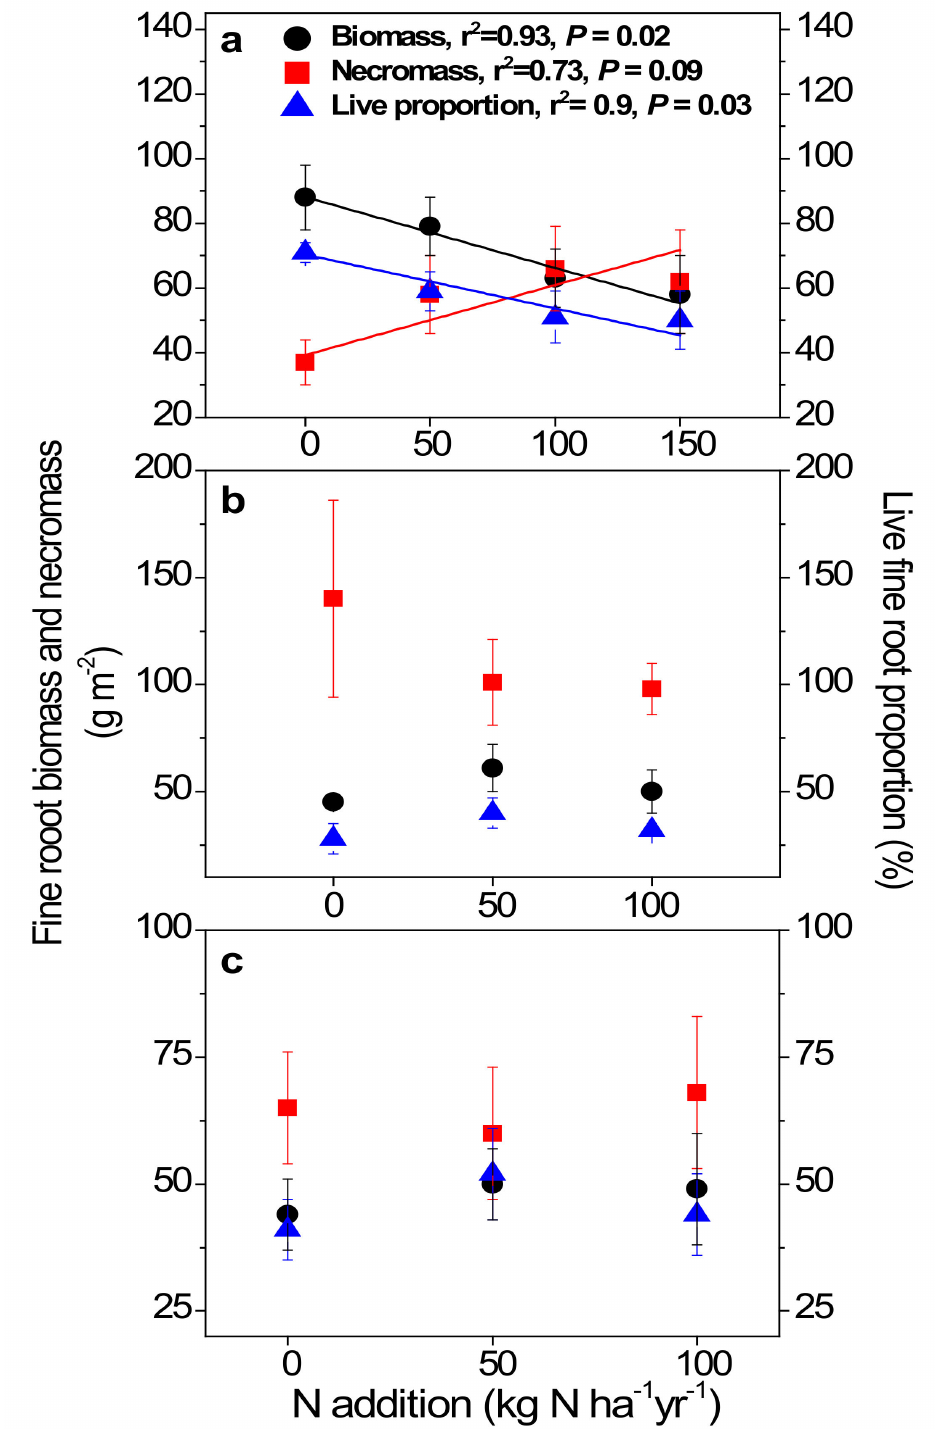
Figure 3. Fine root biomass, necromass, and live fine root proportion (vitality) in the 0–10 cm mineral soil of the primary forest ( a ), the secondary forest ( b ), and the planted forest ( c ) in southern China following 8 years of N addition. Lines represent significant least-squares linear regression fits, with goodness of fit (r 2 ) and P values reported above the lines. Error bars show SE (n = 3). Fine root N content (%) ranged from 0.63% to 1.47% in control plots in these forests and were elevated by 21% after high-N treatment in the primary forest, and by 37% and 35% after medium-N treatments in the secondary forest and in the planted